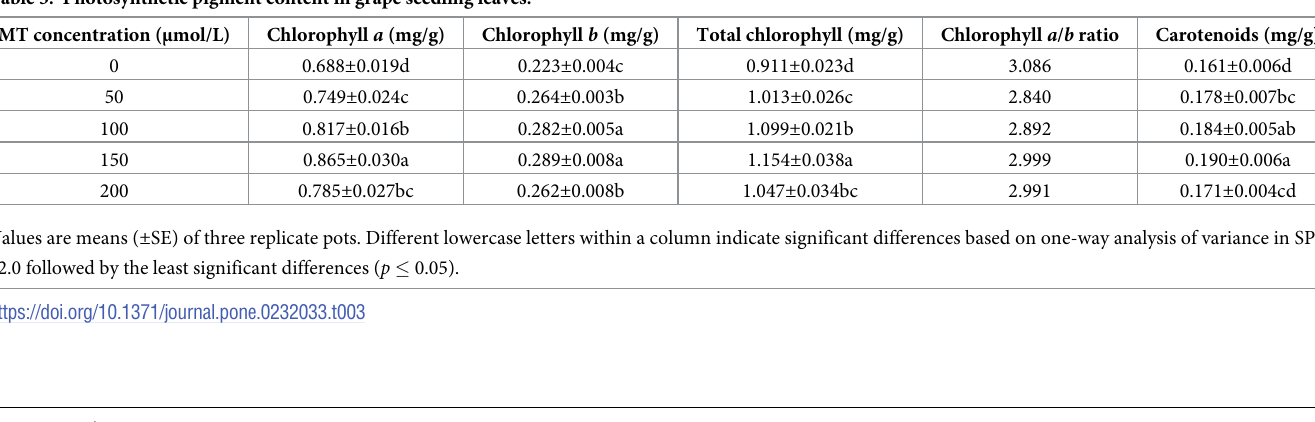
Table 3. Photosynthetic pigment content in grape seedling leaves.